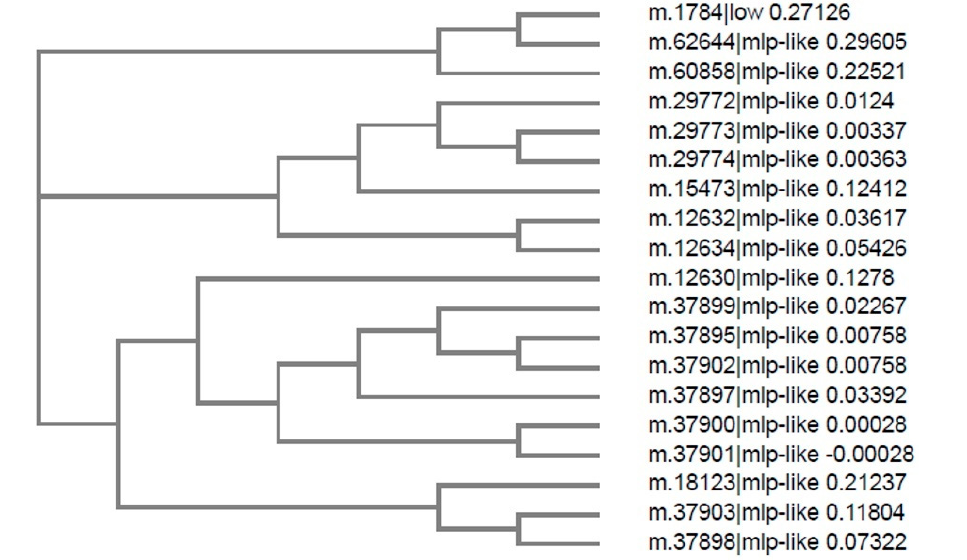
Figure 4. Phylogenetic tree showing relationships between 19 MLP-like sequences from C. majus . C. majus database accession numbers are shown (http://webblast.ipk-gatersleben.de/chelidonium/, accessed on 28 October 2021).